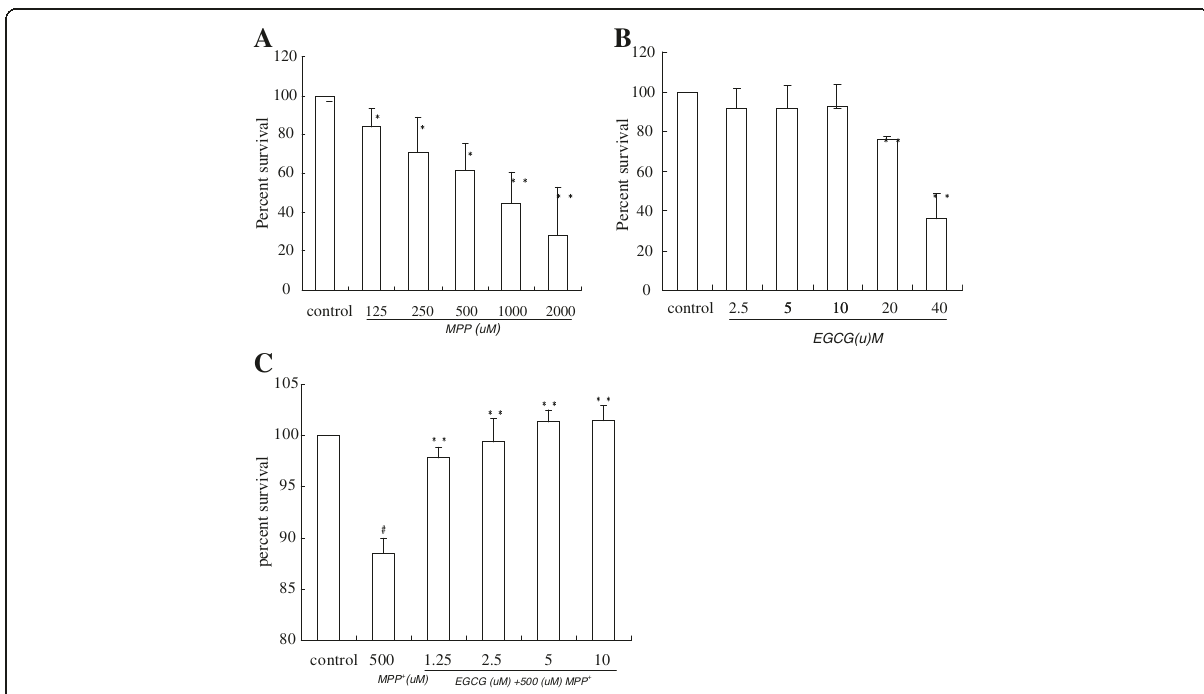
Figure 1 EGCG and MPP + affect PC12 cell viability. (A) MPP + -induced PC12 cell viability. MPP + concentrations were 0, 125, 250, 500, 1000 and 2000 μ mol/L (*P < 0.05;**P < 0.01 vs. vehicle control). (B) PC12 cell viability after EGCG treatment. EGCG concentrations were 0, 2.5, 5, 10, 20 and 40 μ mol/L (**P < 0.01 vs. vehicle control). (C) Treatment with EGCG and then MPP + affects PC12 cell viability. Groups were: control, 500 μ mol/L MPP + , 500 μ mol/L MPP + + EGCG (1.25, 2.5, 5 or 10 μ mol/L) (#P < 0.05 vs. vehicle control, **P < 0.01 vs. MPP + treatment